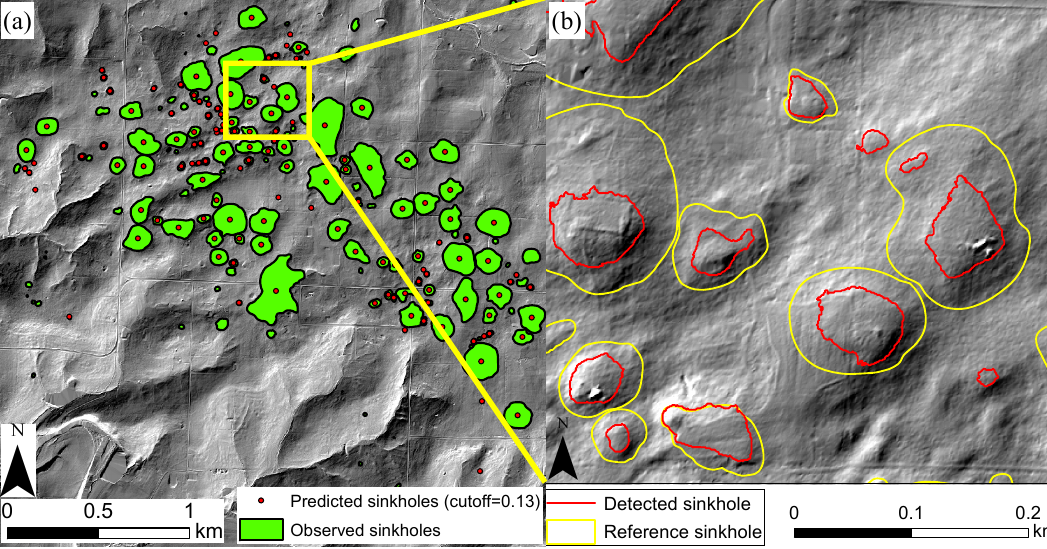
Figure 8. Map of ( a ) sinkhole susceptibility with cutoff of 0.13; and ( b ) reference sinkholes (yellow) and detected sinkholes by GLM model (red).